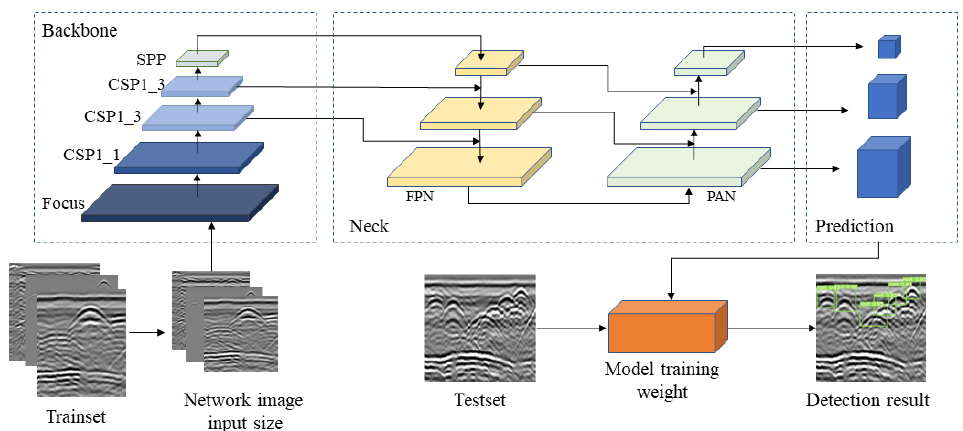
Figure 4. YOLOv5s network structure diagram.